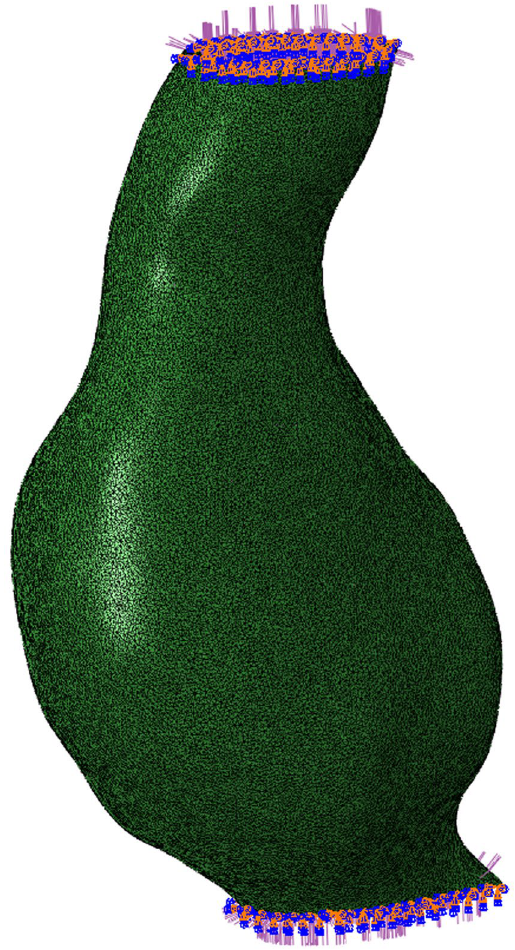
Figure 14. Example of Abaqus model, showing constraints applied on the top and bottom surfaces of the AAA. Definitions of the important surfaces in the model (where loads and boundary conditions are applied) are created by the software and available to the user in the generated input